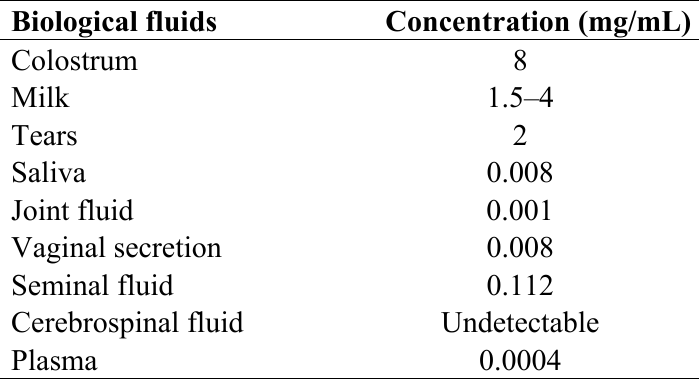
Table 1. Lactoferrin concentrations in human